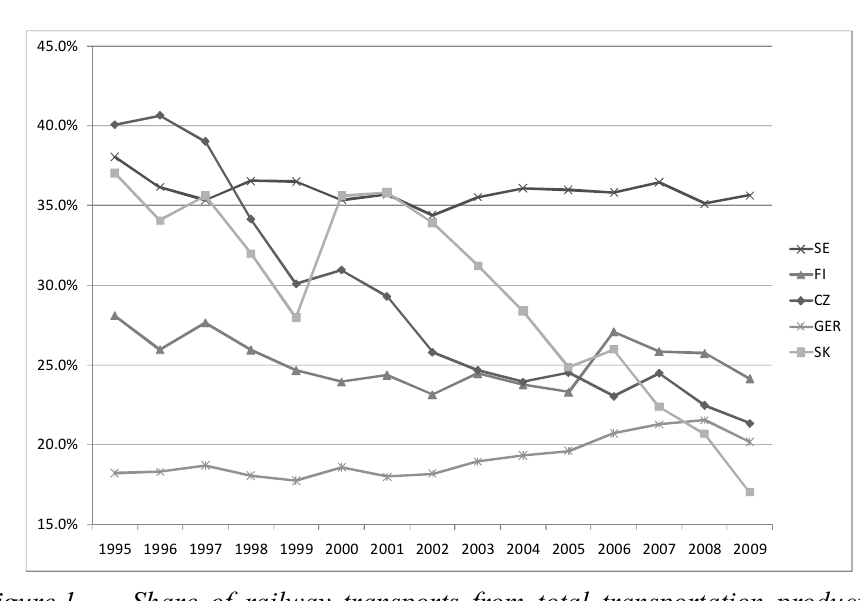
Figure 1 – Share of railway transports from total transportation production (incl. railways, road, inland waterways and pipelines) during years 1995-2009 in selected EU countries of interest. Source (data): European Union – Eurostat (2011)